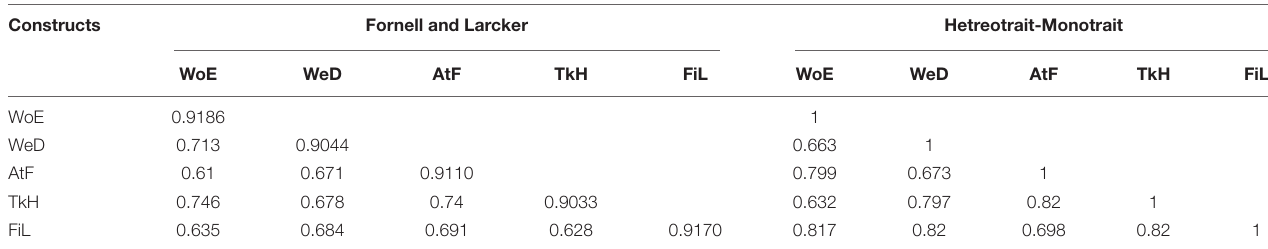
TABLE 7 | Discriminant